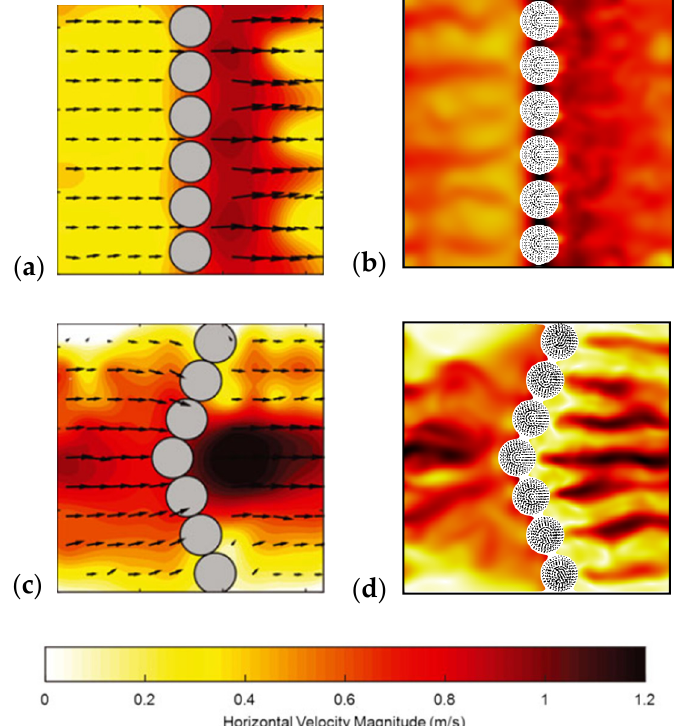
Figure 6. Plan view of the horizontal velocity magnitude at z = 0.08 m plane. ( a ) HOR experiment ( b ) HOR model, ( c ) VUS experiment, ( d ) VUS model. Dots in ( b ) and ( d ) represent solid particles of spheres. Figure 6a,c are taken from the reference study.